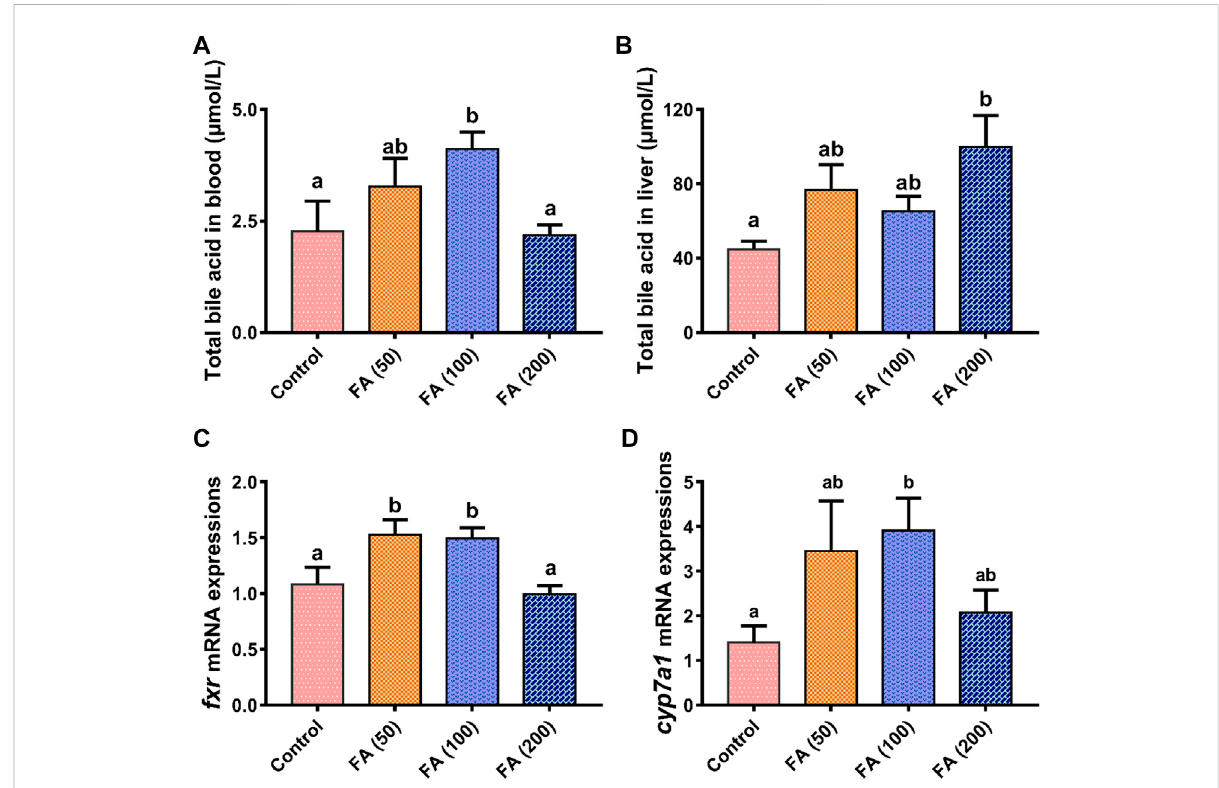
FIGURE 4 Total bile acid levels in blood (A) and liver (B) and relative mRNA expression of farnesoid X receptor ( fxr ; (C) and cholesterol 7 α -hydroxylase ( cyp7a1 ; (D) in the liver of grass carp fed CSM-based diets containing graded levels of ferulic acid. Control: high CSM diet; FA (50): high CSM